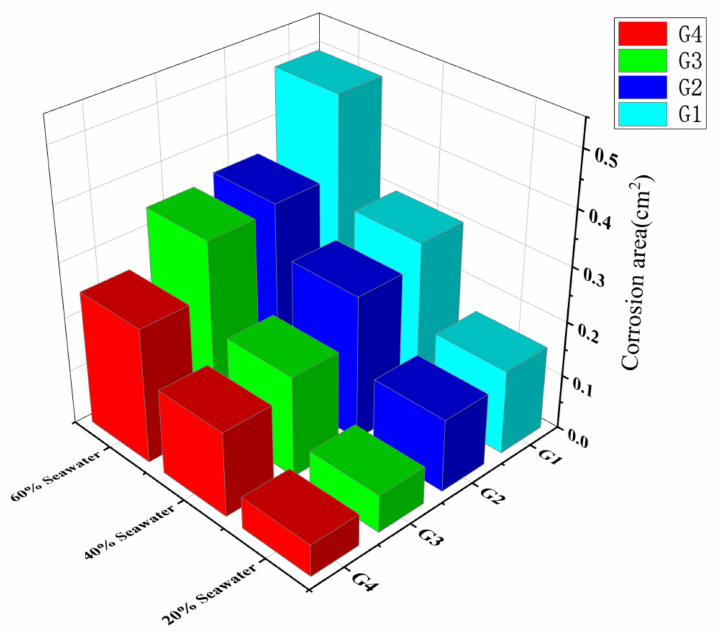
Figure 20. The corrosion area of G1, G2, G3, and G4 immersed in simulated seawater